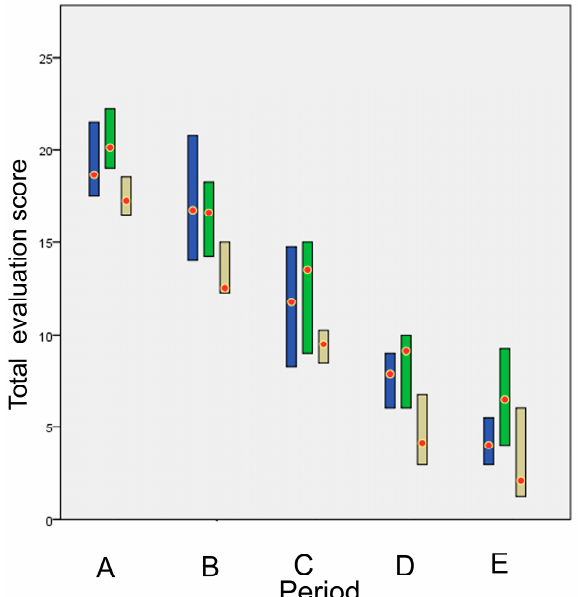
Figure 18. Median (red dot) and interquartile range (column) of total evaluation score for each technique (blue: staples, green: glue, gray: intradermal) in each time period. [period A: 1–8 po.d.; period B: 9–21 po.d.; period C: 22–63 po.d.; period D: 64–180 po.d.; period E: 181–365 po.d.]. Glue